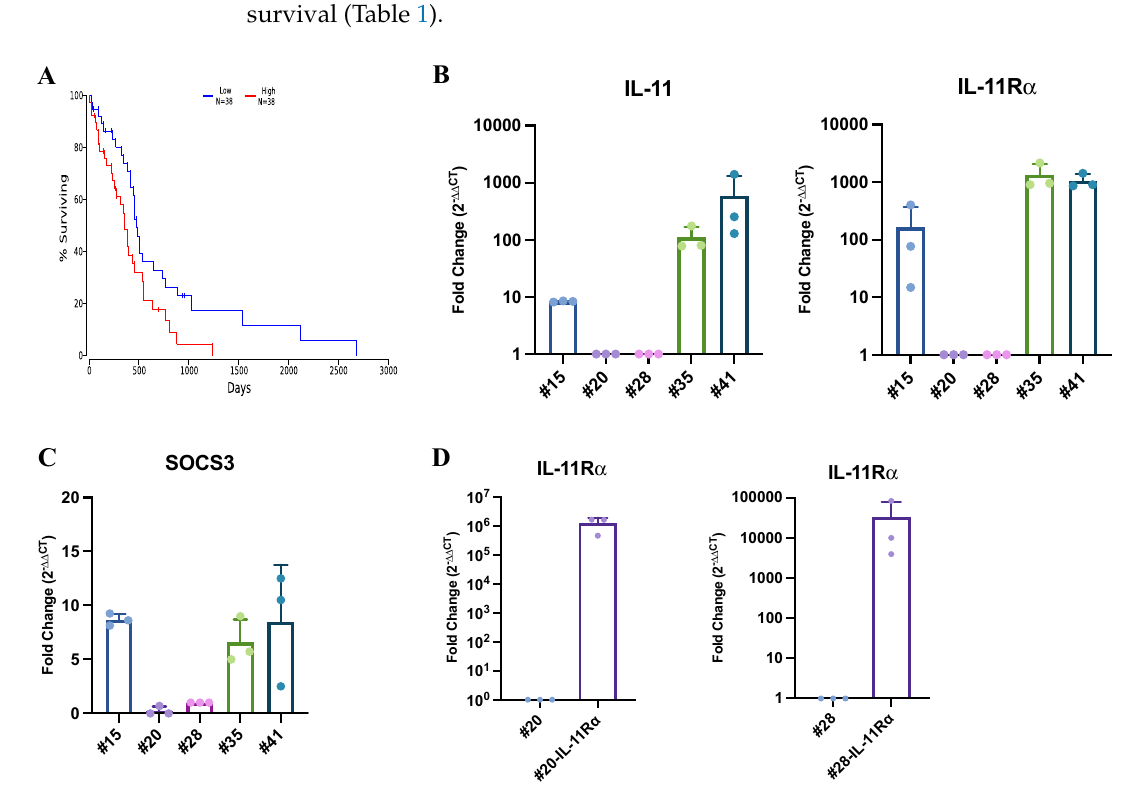
Figure 1 . IL-11 expression correlates with poorer survival in glioblastoma patients. ( A ) The relationship between high (red) and low (blue) IL-11 gene expression with patient survival was determined through mining the Oncolnc TCGA dataset. Kaplan–Meier survival curves were evaluated from the TCGA, n = 76; p = 0.018. ( B ) Gene expression levels of IL-11 and IL-11R α and ( C ) IL-11-stimulated SOCS3 were determined in primary glioblastoma cell lines #4, #20, #28, #35 and #41. ( D ) #20, #20-IL-11R α , #28 and #28-IL-11R α cells were assessed for IL-11R α gene expression. Table 1. IL-11 staining with IHC of glioblastoma patient sections.